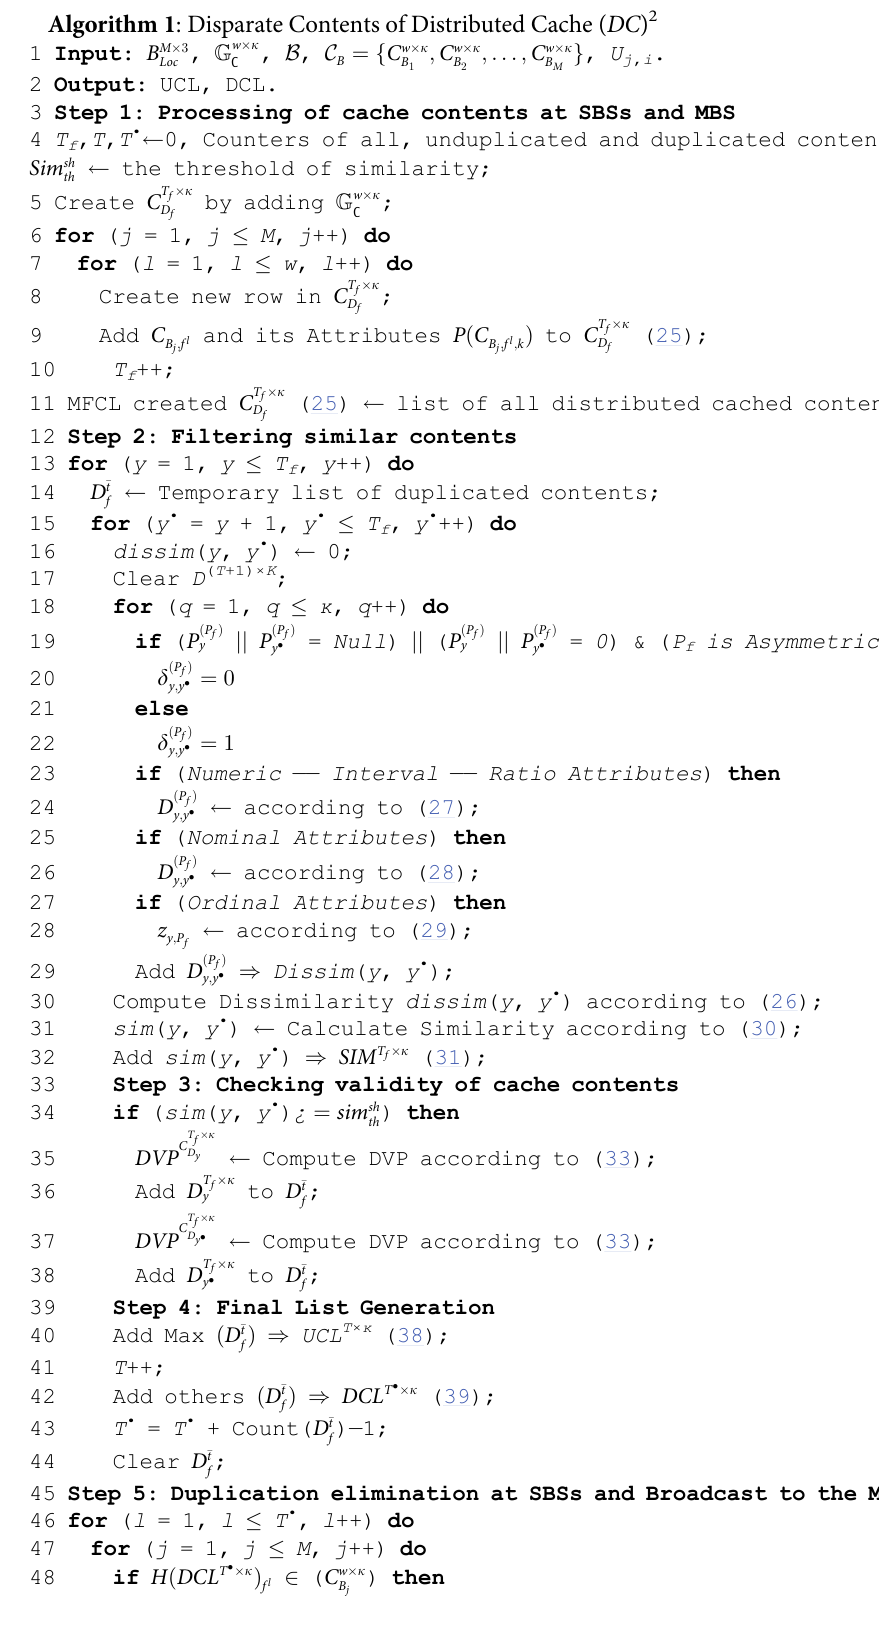
Algorithm 1 : Disparate Contents of Distributed Cache ( DC )